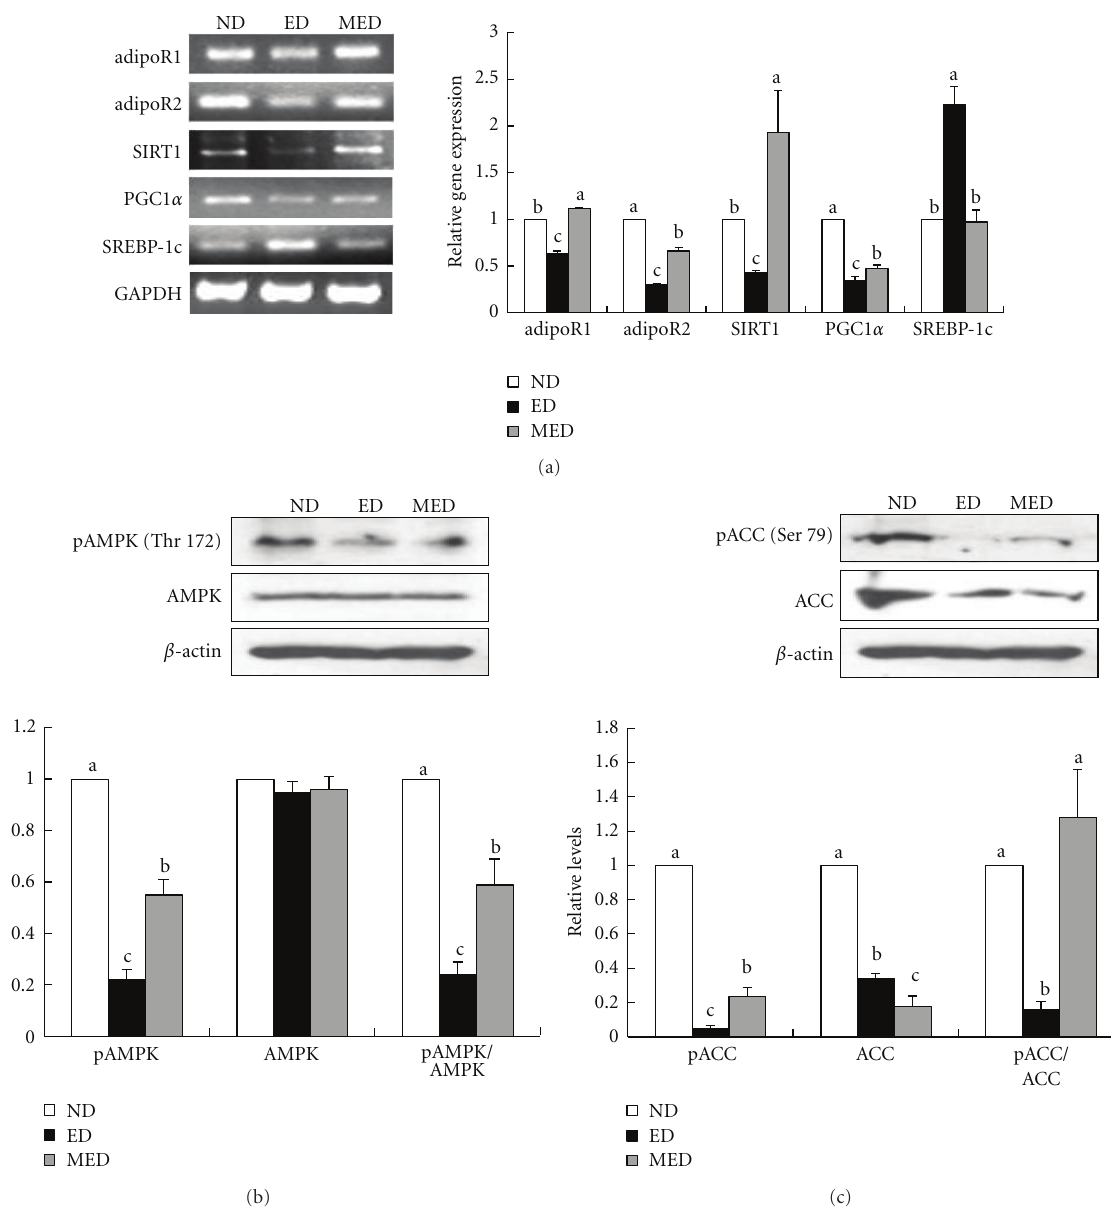
Figure 3: Alcohol-induced liver adiponectin receptors and involved genes in mRNA or protein expression. (a) The left panel shows the results of the RT-PCR analysis of adipoR1, adipoR2, SRIT1, PGC1 α , and SREBP-1c expressions. The images show the representative agarose gel electrophoresis of the PCR products. The right panel shows the relative expressions of the adipoR1, adipoR2, SRIT1, PGC1 α , and SREBP- 1c levels. The data were normalized to the GAPDH levels, and all the expression levels that are shown are relative to the ND. (b) The upper panel shows the results of the Western blot analysis of the phosphorylated and total AMPK. The images show representative Western blotting images. The bottom panel shows the relative expressions of those levels and the ratios of the phosphorylated protein level to the total protein level. (c) The upper panel shows the results of the Western blot analysis of the phosphorylated and total ACC. The images show representative Western blotting images. The bottom panel shows the relative expressions of those levels and the ratios of the phosphorylated protein level to the total protein level. These results represent the means ± SEM of the three independent experiments in which RNA or protein samples from eight mice were used. a,b,c Means not sharing a common letter are significantly di ff erent ( P < 0 .